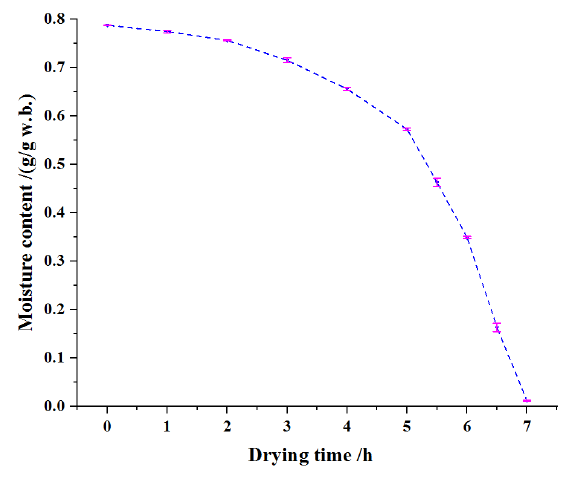
Figure 2. Drying curve of soybean dregs.